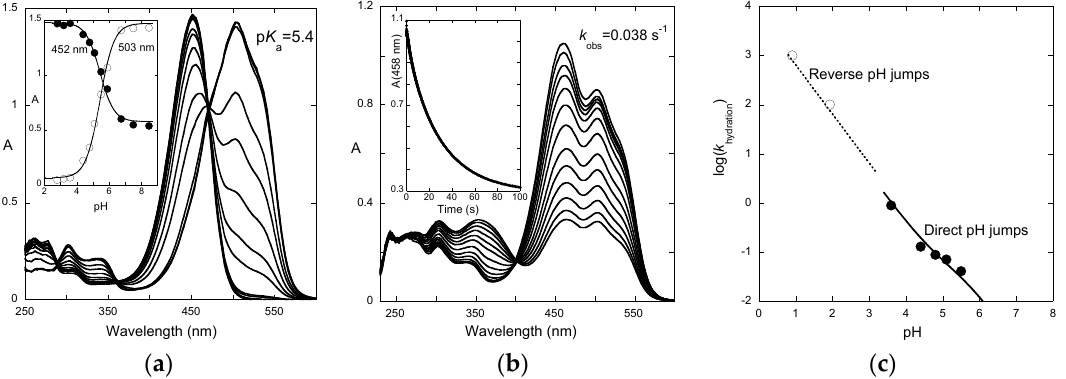
Figure 3. ( a ) pH-Dependence of the UV-visible spectrum of P3 taken 10 ms after a direct pH jump from pH 1.0 to higher pH values. On this timescale, the flavylium cation and the quinoidal base equilibrate with p K a = 5.4; and ( b ) spectral variations upon a direct pH jump from pH 1.0 to 5.5 followed by stopped flow. Mono-exponential curve-fitting gives rate constant k obs = 0.038 s − 1 ; and ( c ) apparent rate constants of hydration for different pH values: ( ● ) direct pH jumps, ( ) reverse pH jumps. Fitting was achieved for k h = 0.08 s − 1 ; k- h = 9 × 10 3 M − 1 ·s − 1 ; p K a set at 5.4, K t set at 0.6. The K t value was calculated from the amplitudes of the curves recorded after a reverse pH jump from pH = 4.65 to pH = 1.9 (Figure 4). The initial absorbance is due to the mixture of flavylium ion and quinoidal base present at pseudo-equilibrium at pH = 4.65. The first step corresponds to fast dehydration at pH = 1.9 (apparent rate constant = 110 s − 1 ). The second step corresponds to the slower tautomerization. From the amplitudes of both steps, the K t value can be estimated: K t = 0.6.